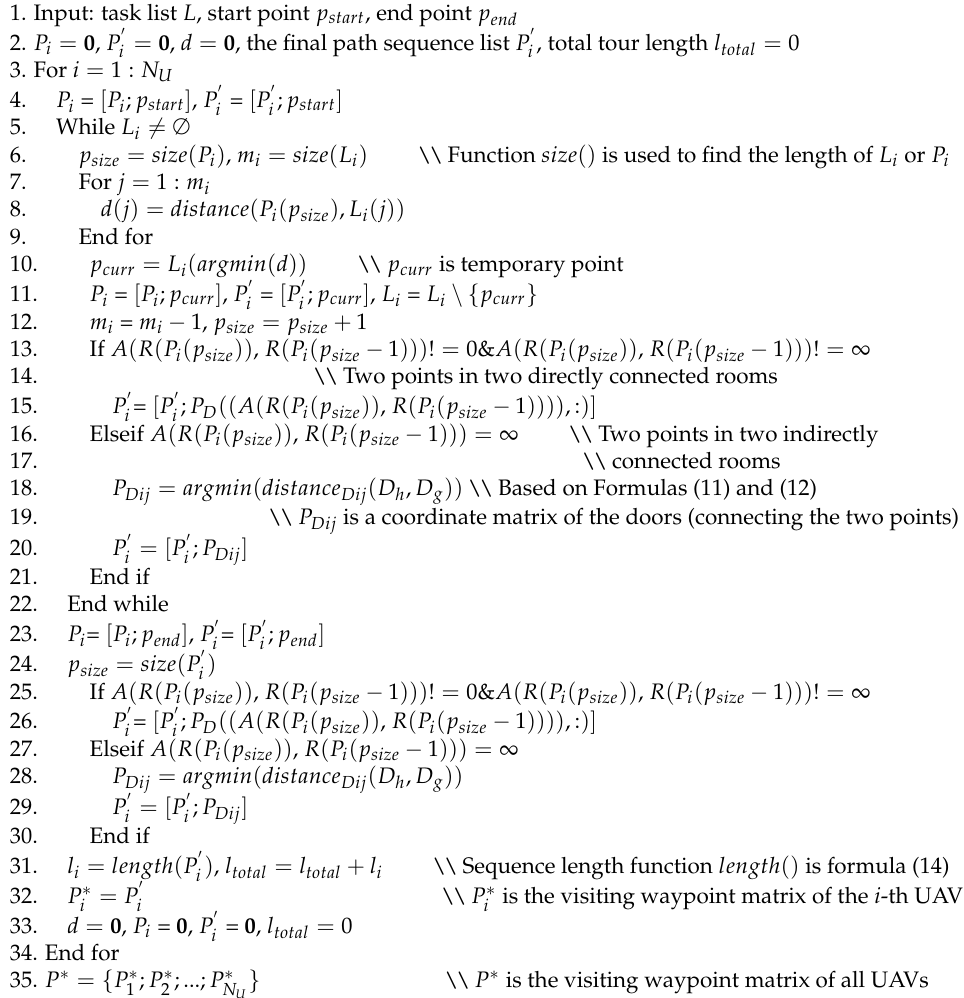
Algorithm 2 Nearest neighbor algorithm based on topological